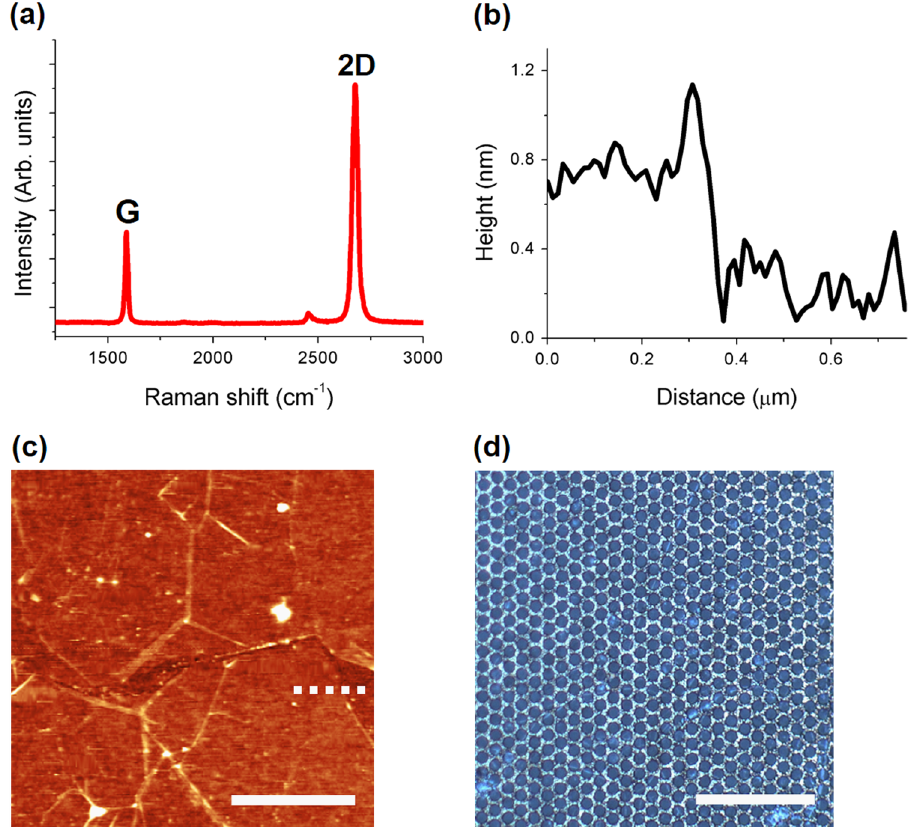
Fig. 2 Graphene substrate characterizations by a Raman spectroscopy, b AFM height pro fi le, c AFM topology and d optical microscopy. Height pro fi le in b is along the dashed line in c . Scale bars in c is 1 μ m, d is 100 μ